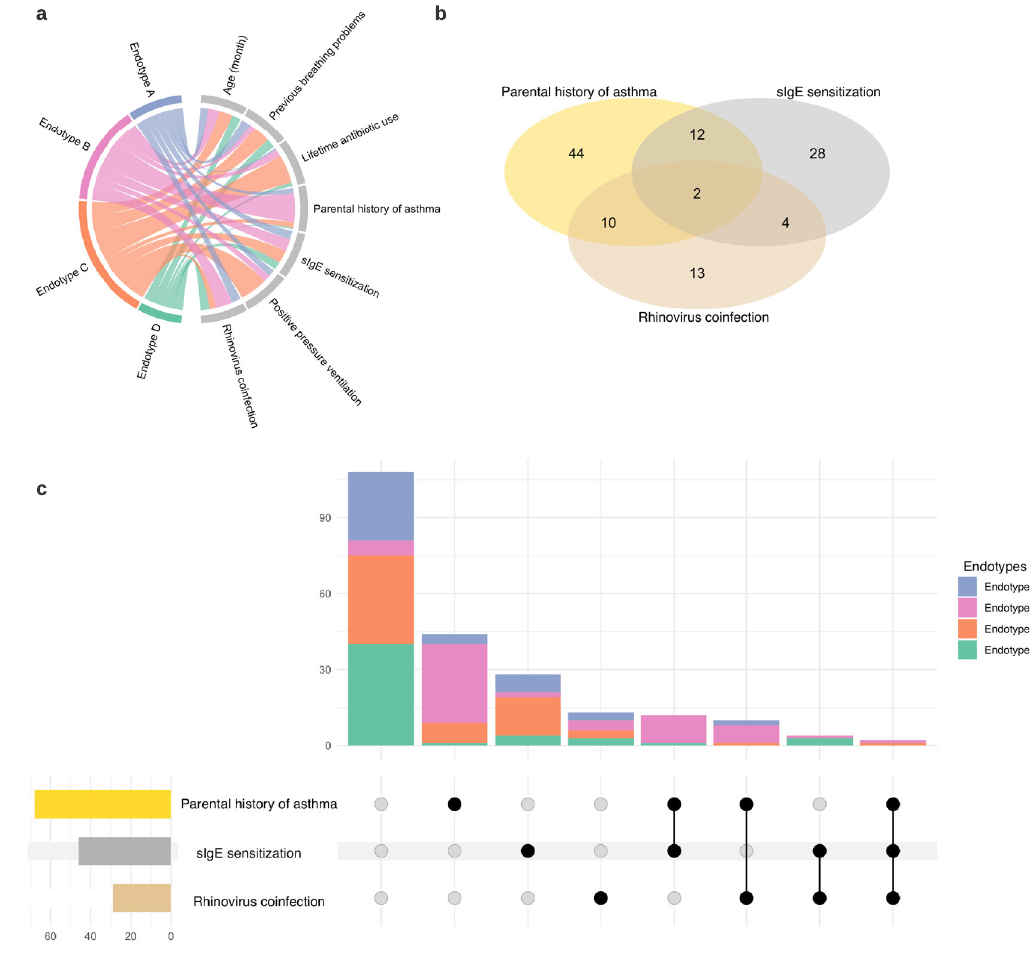
Fig. 3 Relationship between major clinical variables and endotypes. a Chord diagram showing major clinical variables by endotype. The ribbons connect from the individual endotypes to the major clinical and virus characteristics. The width of the ribbon represents the proportion of infants within the endotype who have the corresponding clinical or virus characteristic. Then, it was scaled to a total of 100%. For example, the endotype B infants (light red) had a high proportion of parental asthma, IgE sensitization, and coinfection with rhinovirus. Endotype C (light orange) infants had a high proportion of lifetime antibiotics use and positive pressure ventilation use during the index hospitalization for bronchiolitis. b Venn diagram of three major clinical variables (parental history of asthma, IgE sensitization, rhinovirus infection) and their intersections. The Venn diagram illustrates the composition of three major clinical variables and their intersections. The numbers correspond to the number of infants in each subset and intersection. c Upset plot corresponding to the presented Venn diagram. The plot illustrates the composition of three major clinical variables and their intersections visualized based on the four endotypes. Vertical stacked bar charts re fl ect the number of infants within each subset and intersection colored according to the endotypes. Horizontal bars indicate the number of infants in each clinical variable set. Black dots indicate the sets of subsets and intersections; connecting lines indicate relevant intersections related to each stacked bar